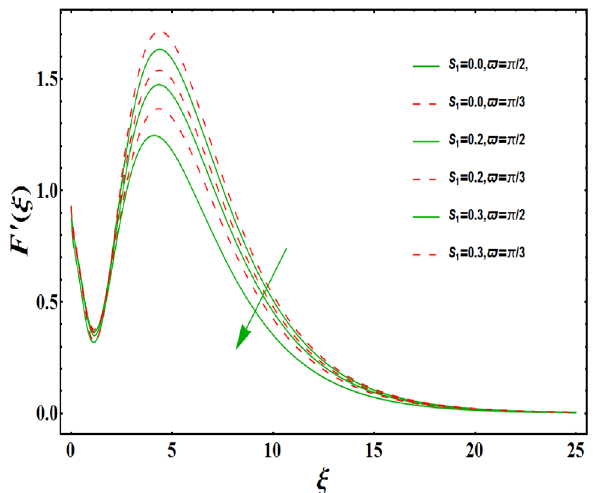
Figure 7. Variation of S 1 on F ′ (ξ) for both with and without inclanation.